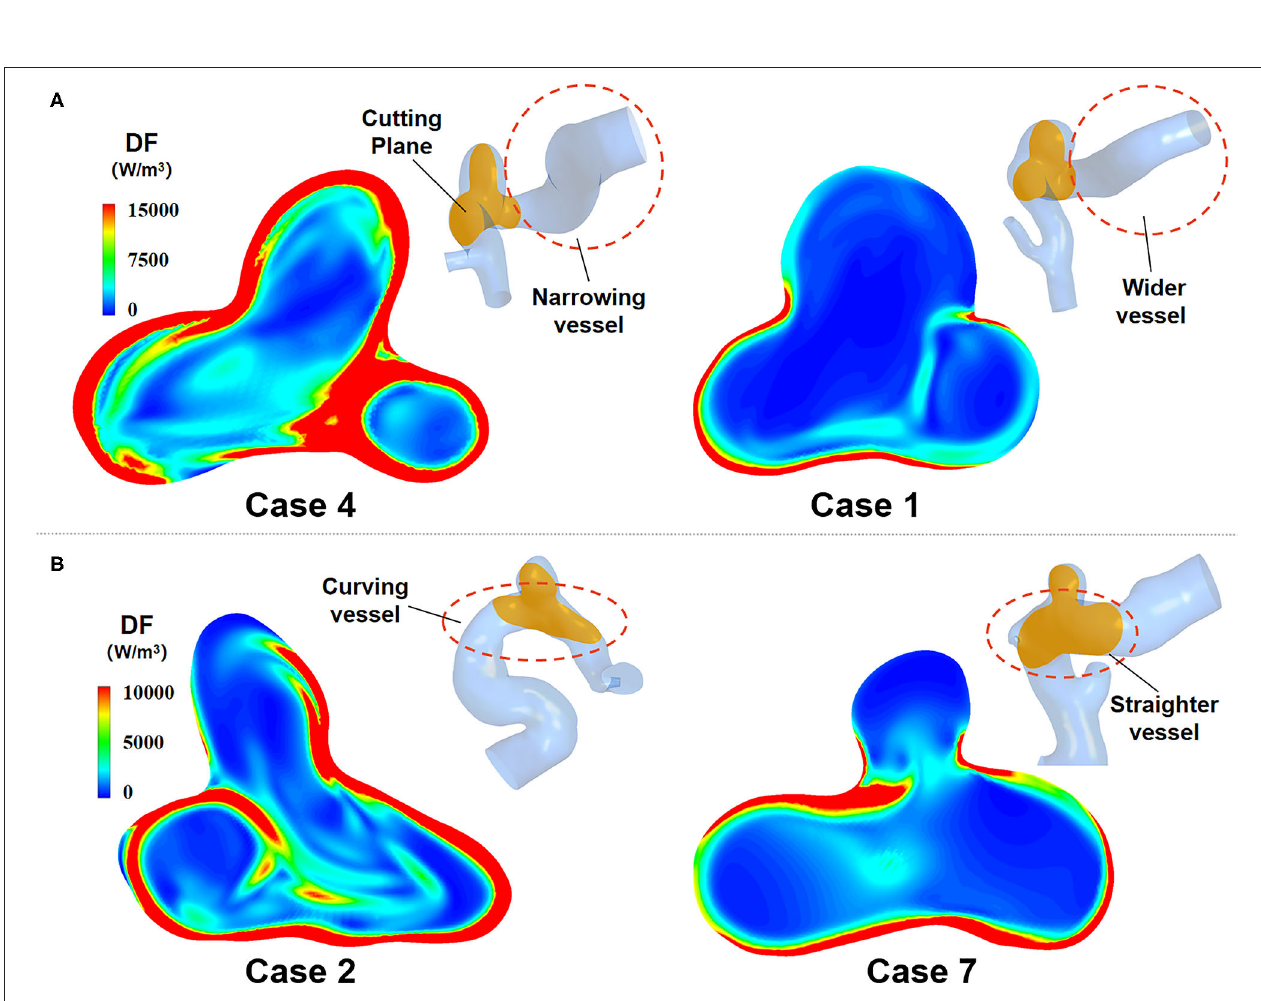
Frontiers in Neurology |